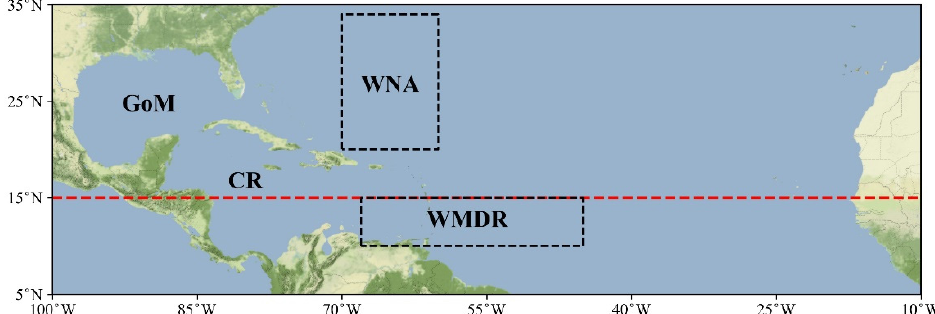
Figure 2. The domain of the North Atlantic Ocean considered for this study and four study regions: Gulf of Mexico (GoM), Caribbean region (CR), Western North Atlantic (WNA), and Western Main Development region (WMDR). The red line at 15° N shows the geographical division between the Tropics from Subtropics used for this work.